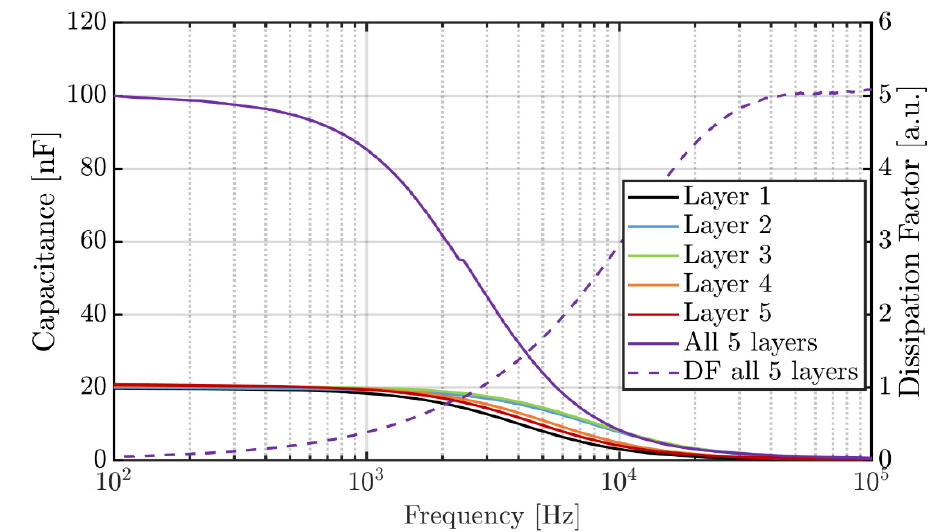
Figure 3. Capacitance and dissipation factor of individual layers and multilayer device.